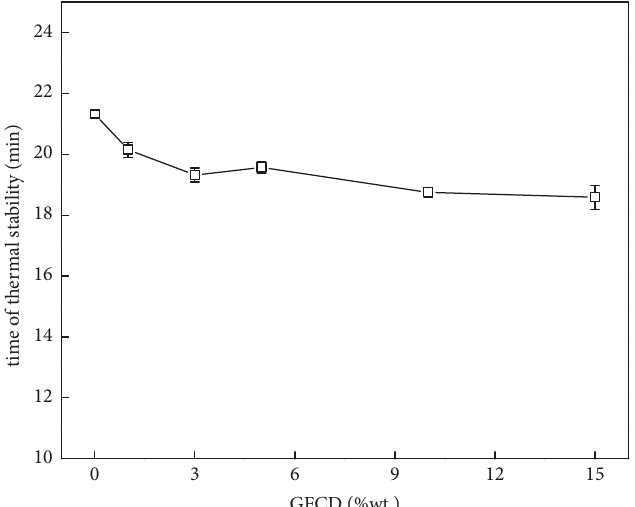
Figure 6: The relationship between the time of thermal stability of composite materials and the GFCD content in